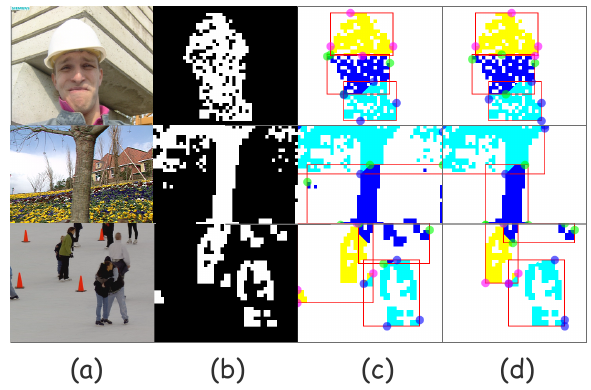
Figure 8. Visual effects before and after the pruning algorithm for motion areas: ( a ) Raw sequences. (From top to bottom: Suzie , Ice , Foreman ) ( b ) Foreground motion blocks. ( c ) Before pruning. ( d ) After pruning.